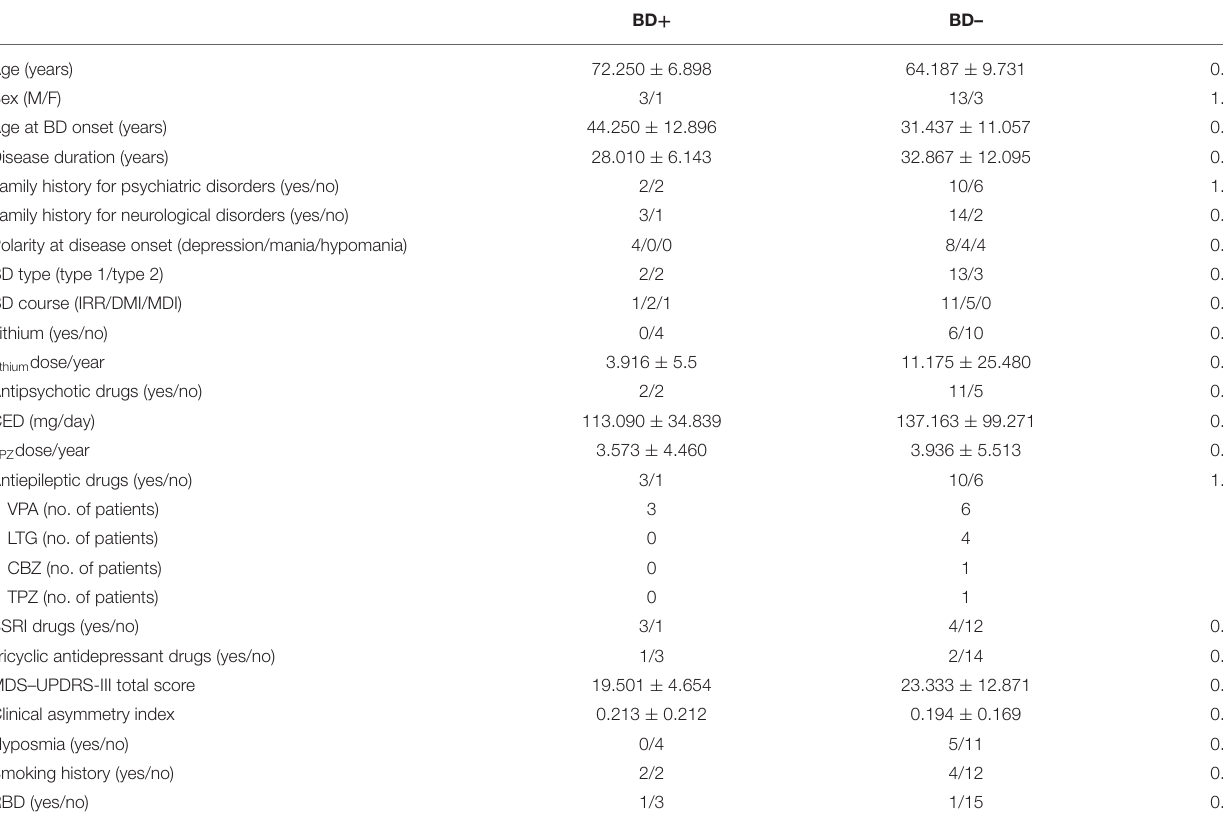
TABLE 1 | Demographic and clinical comparisons between BD patients with (BD + ) and without (BD–) evidence of dopaminergic